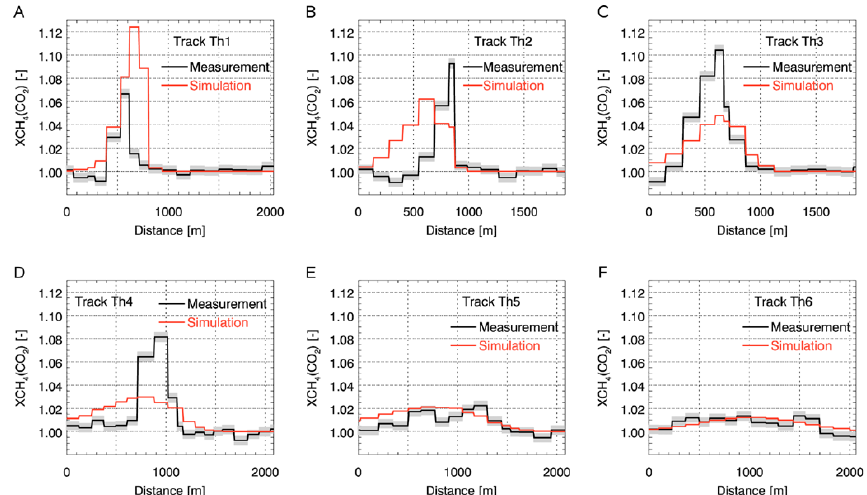
Fig. 14. Measurement (black) with according precision (grey) and plume model simulations (red) using the inversion results along horizontal cross sections through the CH 4 plume originating at Theodor Shaft. The position of the cross section tracks is specified in Fig. 12.